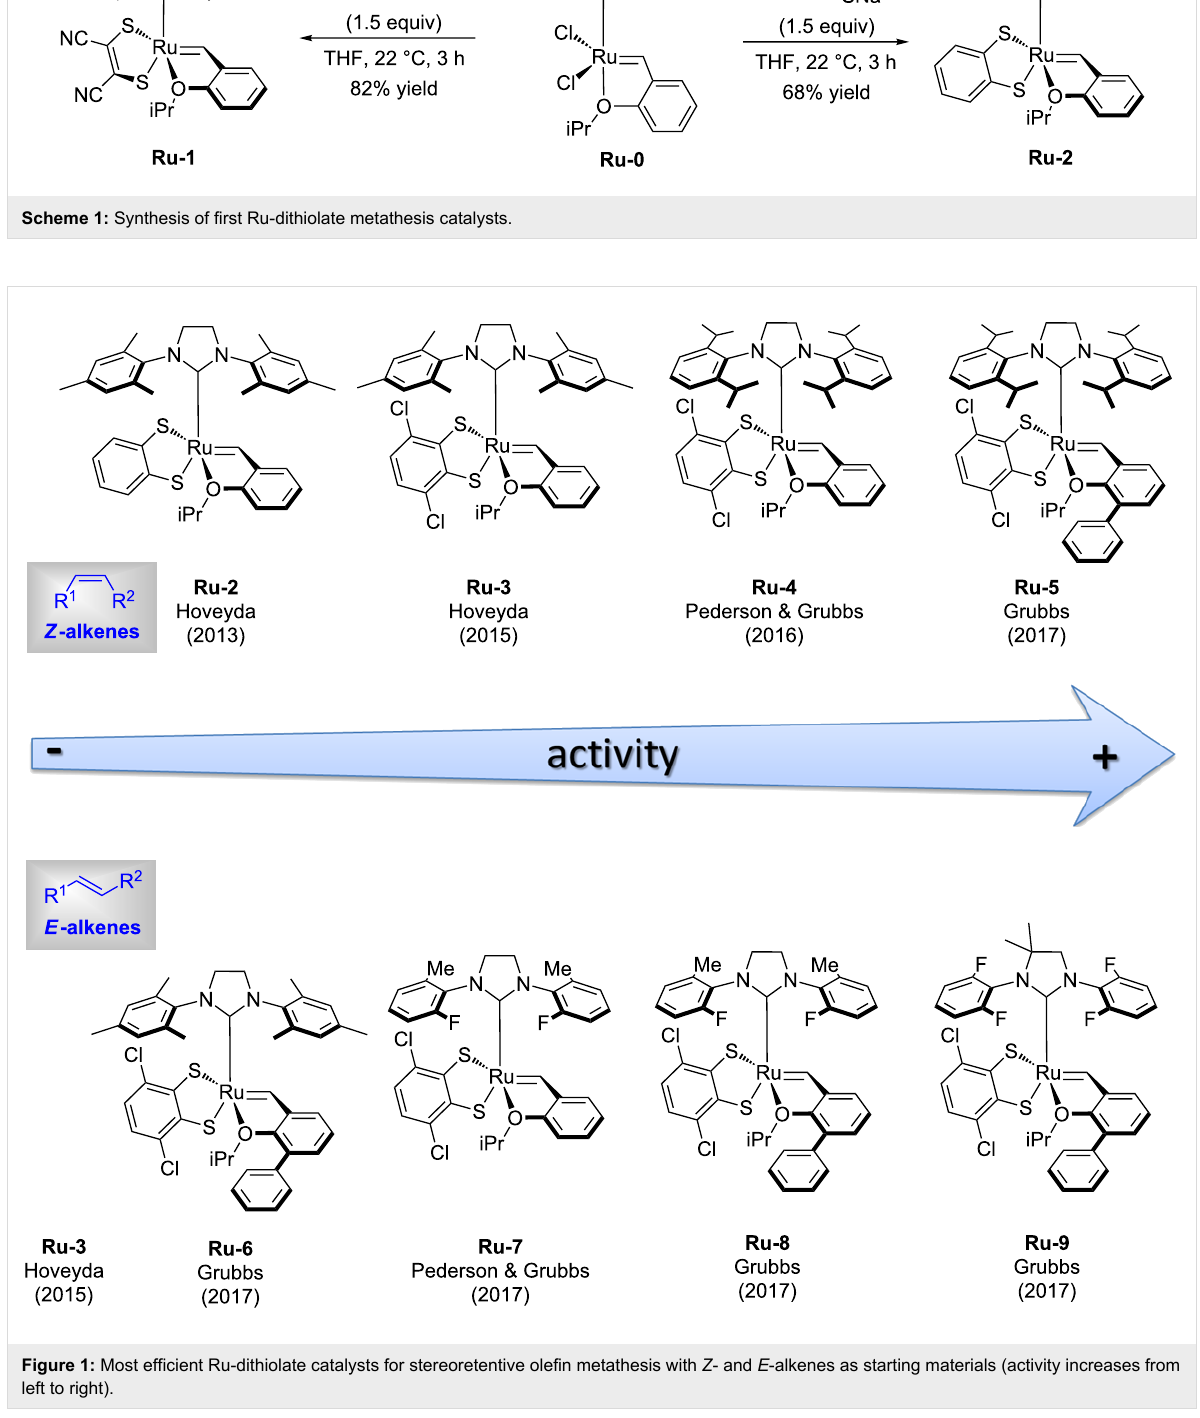
moderate to good catalytic activity and can therefore be consid- ered as a relatively general catalyst (Figure 1). In 2016 Pederson and Grubbs reported SIPr-based catalyst Ru-4 with